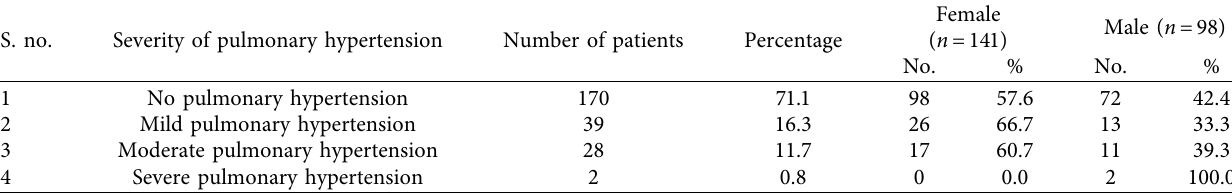
Table 3: Prevalence and severity of pulmonary hypertension (mPAP ≥ 25mmHg).